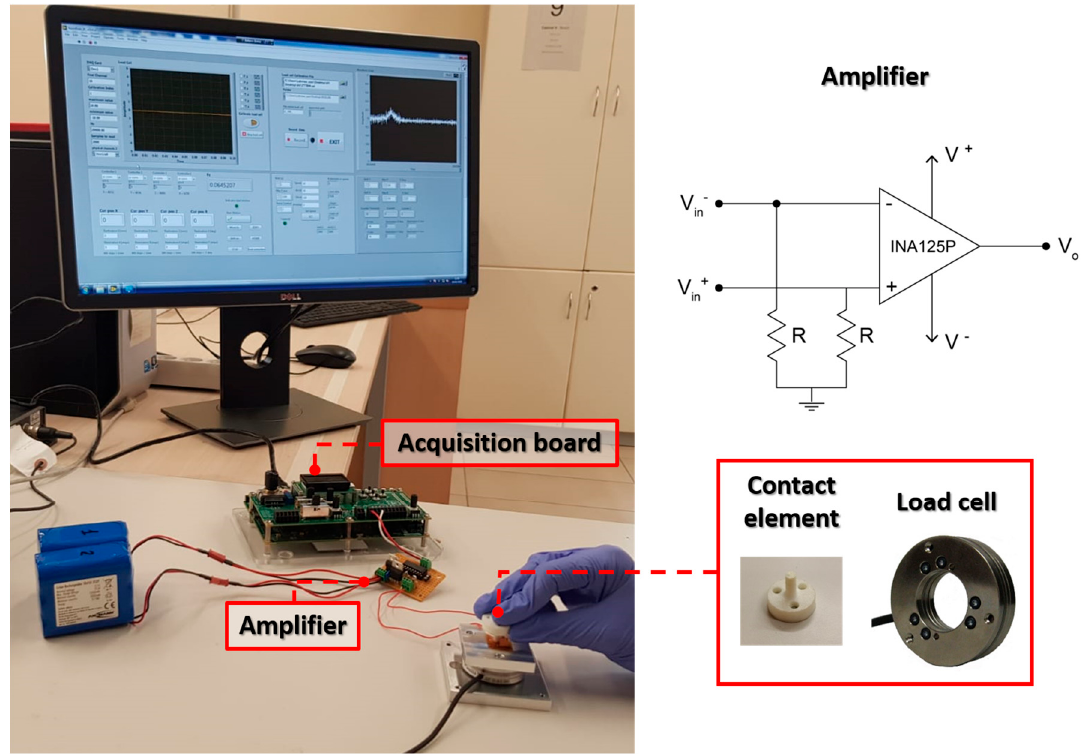
Figure 2. Experimental setup for sensor data acquisition during pressure-sensing (and vibration) test.